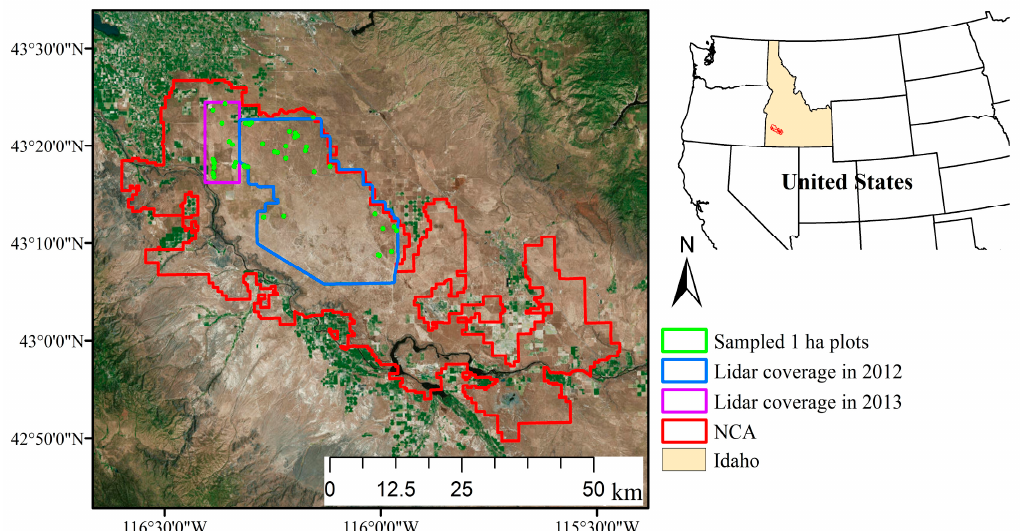
Figure 1. The Morley Nelson Snake River Birds of Prey National Conservation Area (NCA), located in southwestern Idaho, USA. This study area is located in the northwestern portion of the NCA where the 2012 and 2013 Lidar data were obtained.